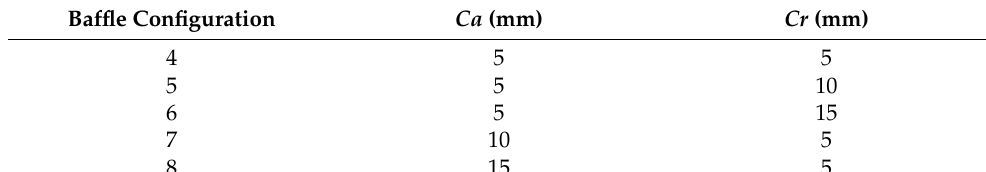
Table 2. Baffle configurations with different axial clearances and radial clearances.